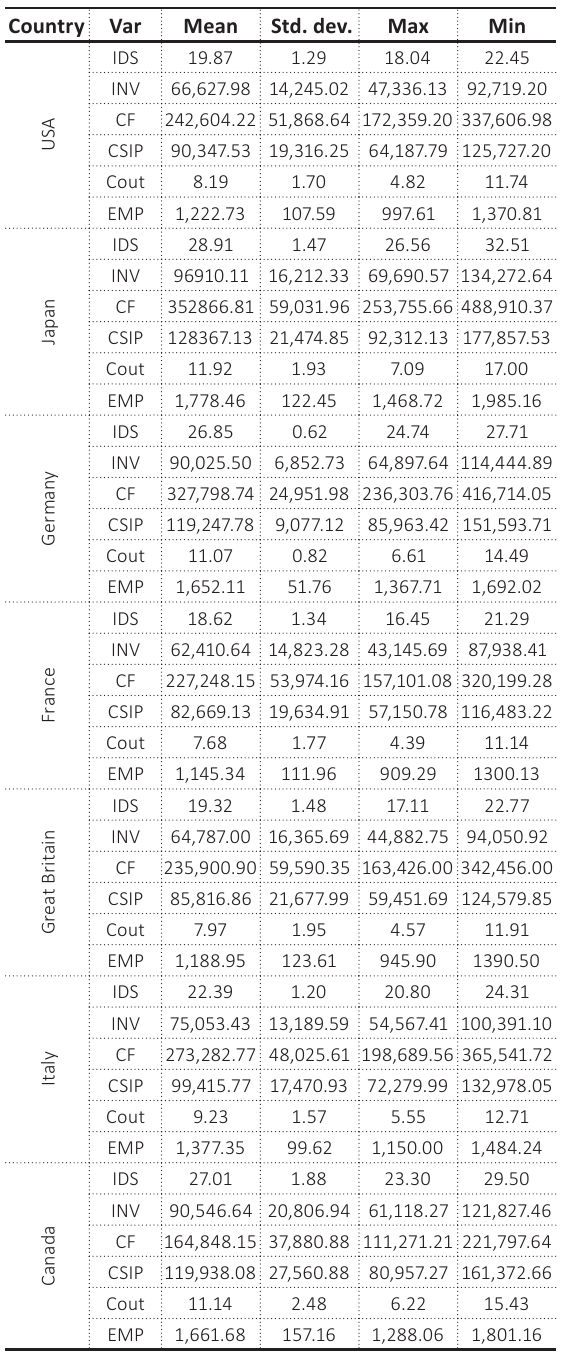
Table 2. Descriptive statistics for the